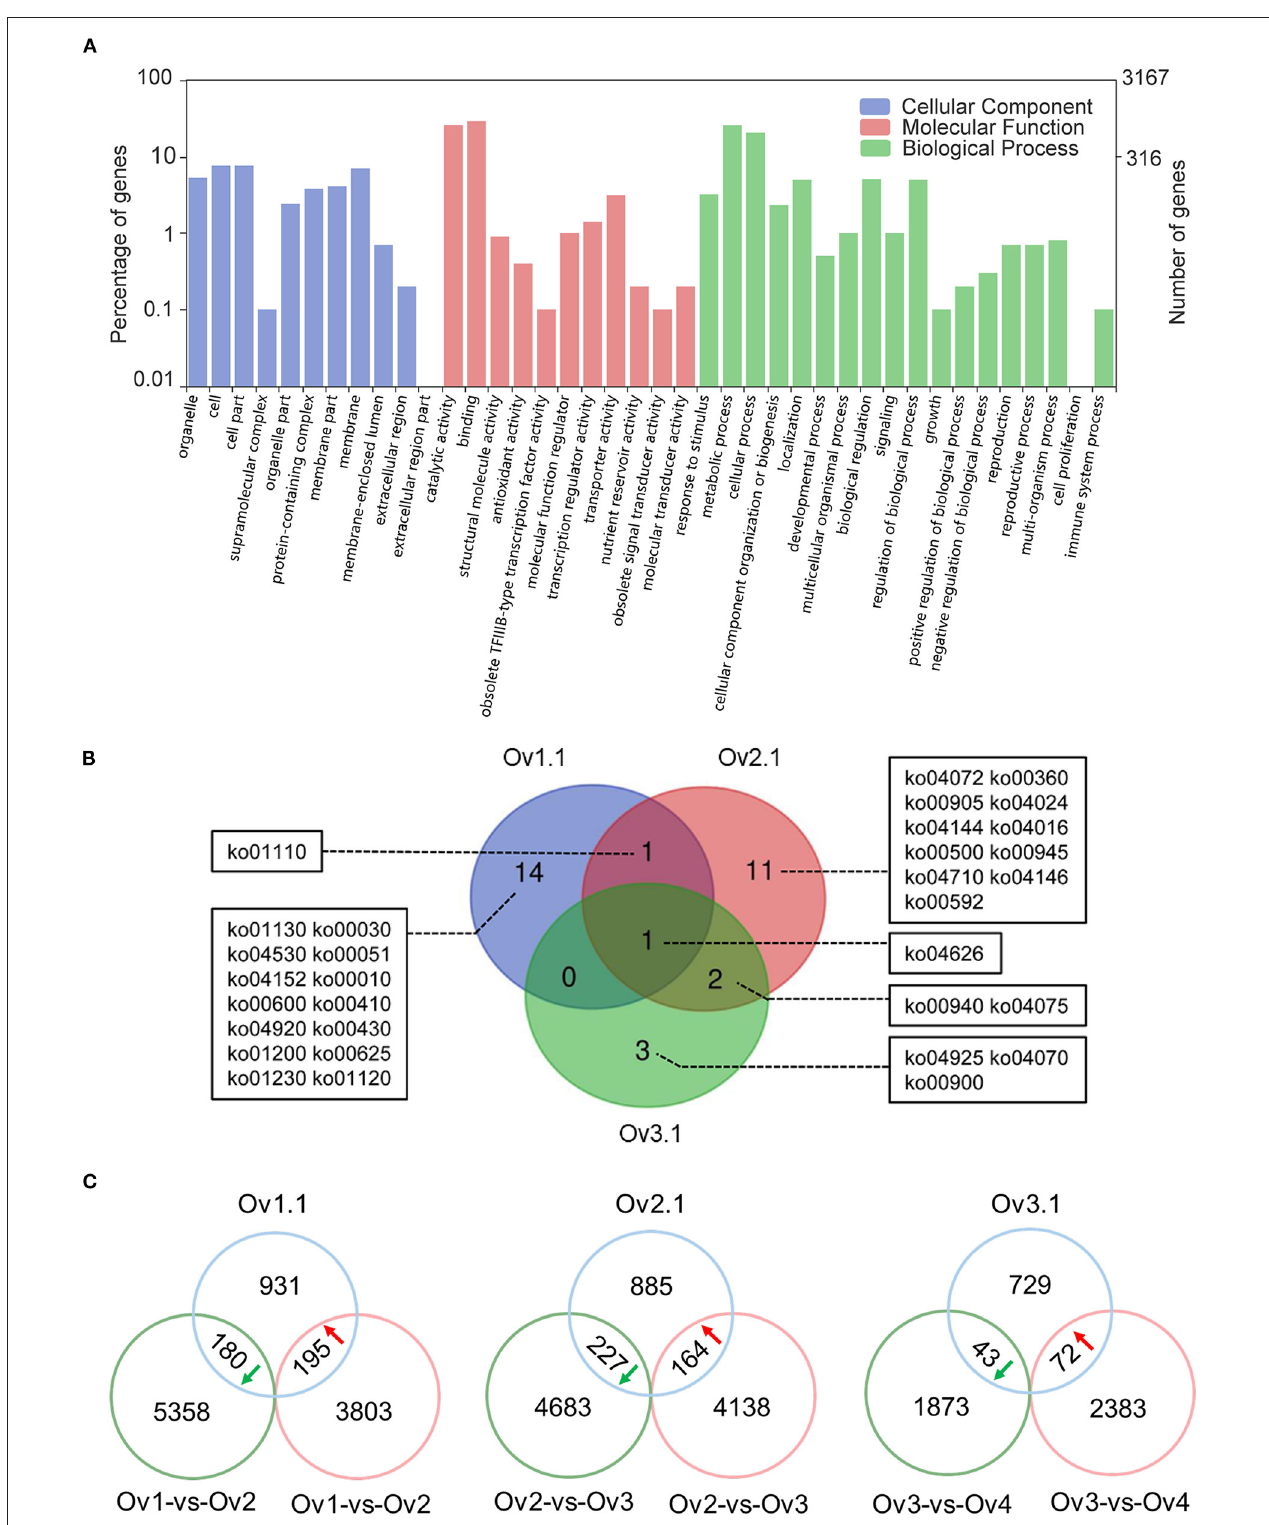
FIGURE 6 | GO and KEGG enrichment and ChARF3-regulated genes analysis. (A) GO classification of all ChARF3 target genes. (B) Overlaps of significantly enriched KEGG pathways at three ovule development stages. ko00010: Glycolysis/Gluconeogenesis, ko00030: Pentose phosphate pathway, ko00051: Fructose